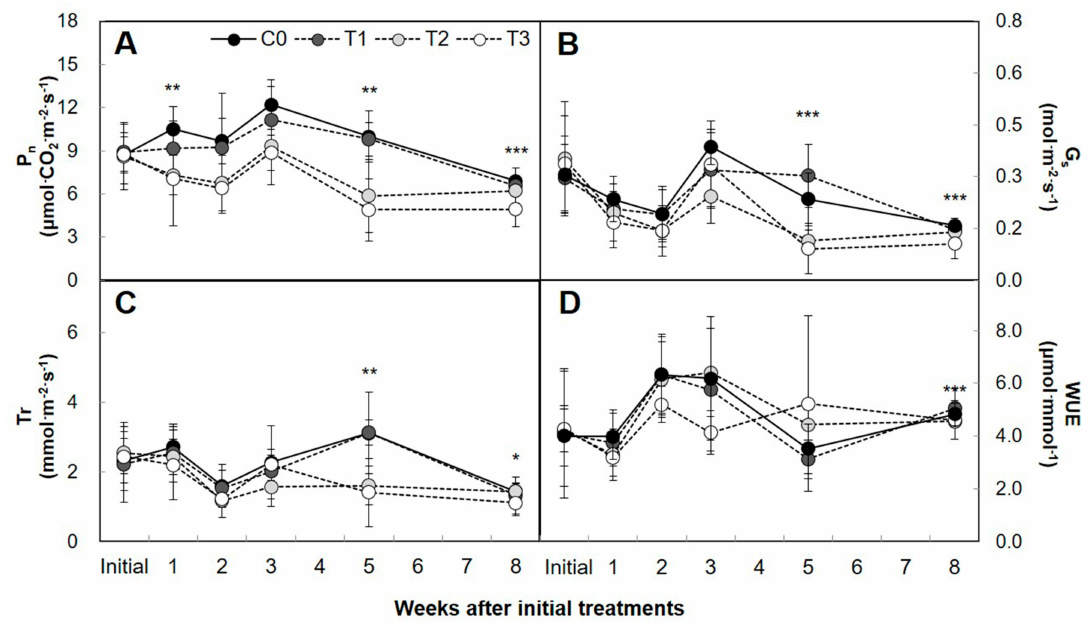
Figure 6. Seasonal patterns of leaf gas exchange parameters in yellow-poplar treated with artificial night lighting. ( A ) Net photosynthetic rate (Pn), ( B ) stomatal conductance (Gs), ( C ) transpiration rate (Tr), and ( D ) water use efficiency (WUE) of yellow-poplar plants exposed to the natural day/night cycle (C0) and the day/night with artificial lighting cycle (T1, T2, and T3) during the experimental period. The black solid circles ( ), gray solid circles ( ), light gray solid circles ( ), and hollow circles ( ) represent C0, T1, T2, and T3, respectively. The x -axis represents the weeks after initial onset (cid:35) of treatments on 22 April 2014. Data points represent mean ± SD of five experimental replicates. Asterisks represent significant treatment effects at a single measuring date (* p < 0.05; ** p < 0.01; *** p <